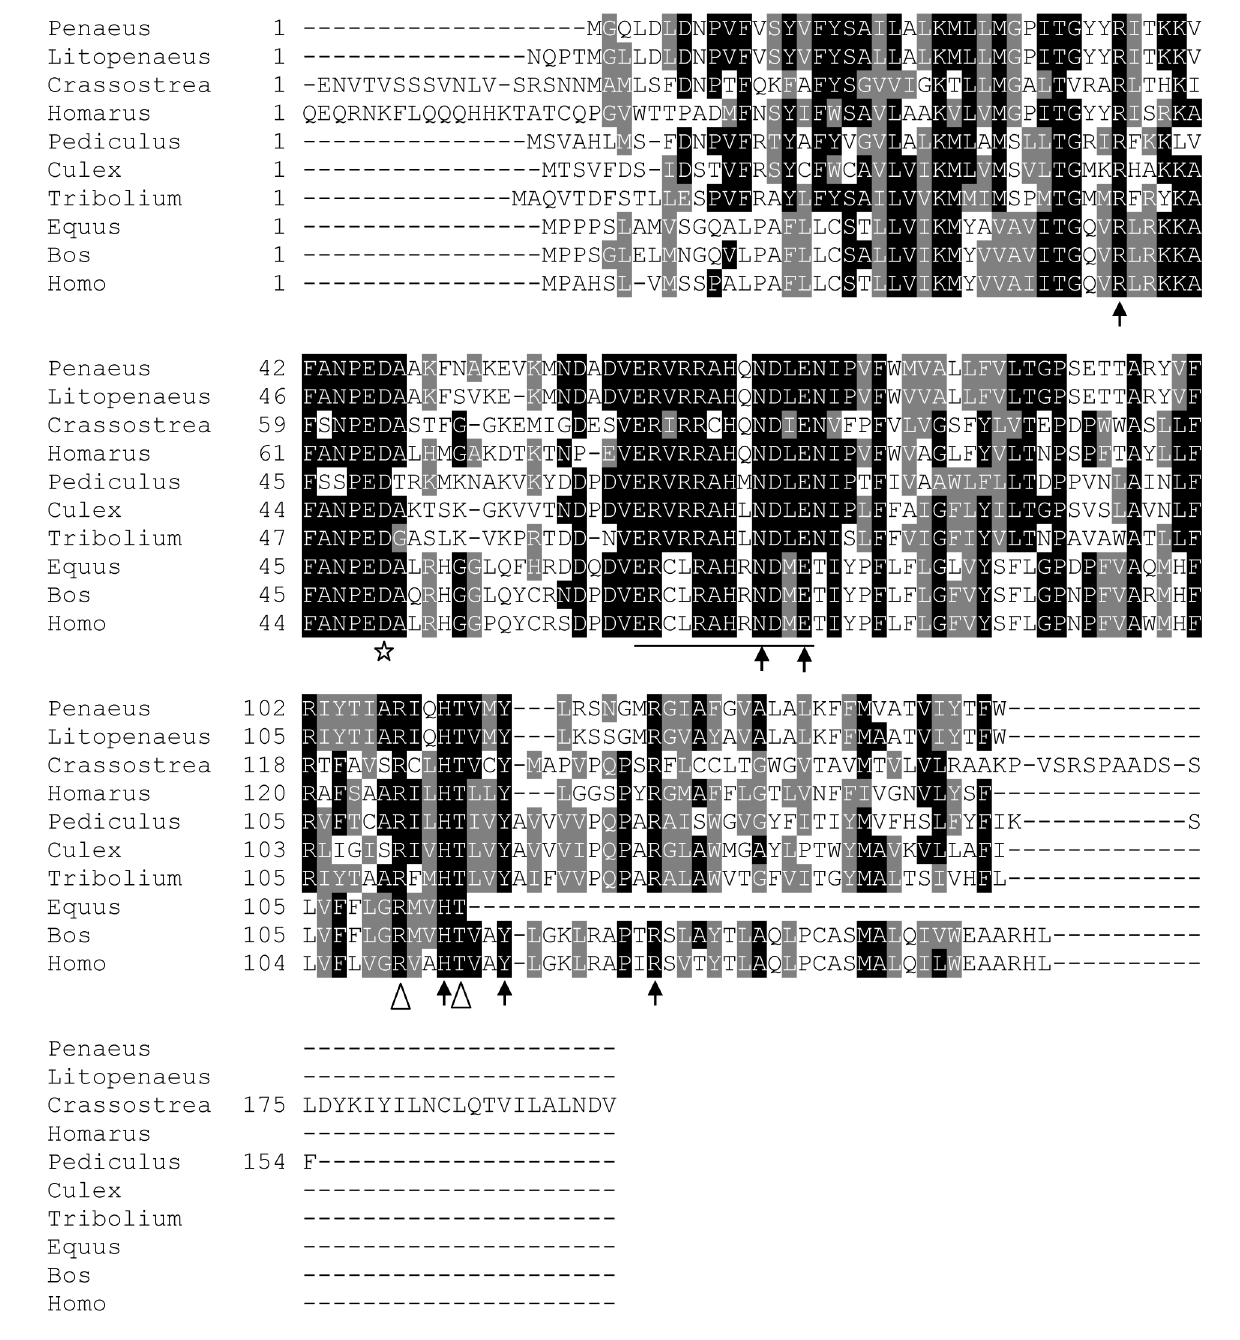
Figure 1. Mapping of essential residues in the predicted P. monodon PGES1 enzyme. Multiple sequence alignments of P. monodon PGES1 and their homologs showed a conserved residue for the MAPEG family (white star), catalytic residues that interact with PGH (white arrow head), essential residues for H-bonding to GSH (black arrows) and consensus sequence required for 2 oxygenation product (underline). Genus and species used in this alignment are abbreviated as followed: Penaeus − P. monodon , Litopenaeus − L. vannamei , Crassostrea − Crassostrea virginica , Homarus − H. americanus , Pediculus − Pediculus humanus corporis , Culex − Culex quinquefasciatus , Tribolium − Tribolium castaneum , Equus − Equus caballus , Bos − Bos taurus and Homo − Homo sapiens .